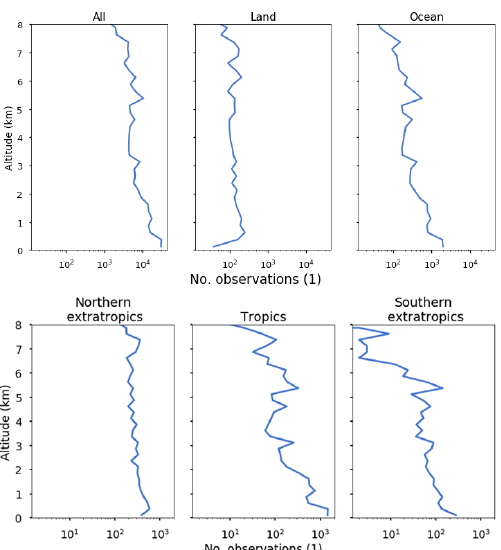
Figure A1. The number of observations (and model points) used in each altitude bin for different subsets of the data used throughout the analysis.